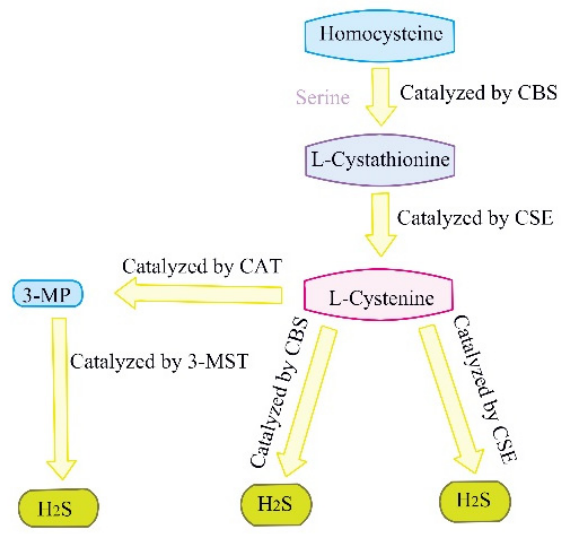
Figure 2. The summary of the production of endogenous H 2 S. CBS: cystathionine-beta-synthase; CSE: cystathionine-gamma-lyase; 3-MST: 3-mercaptopyruvate thiotransferase; 3-MP: 3-mercaptopyruvate; CAT: cysteine aminotransferase.